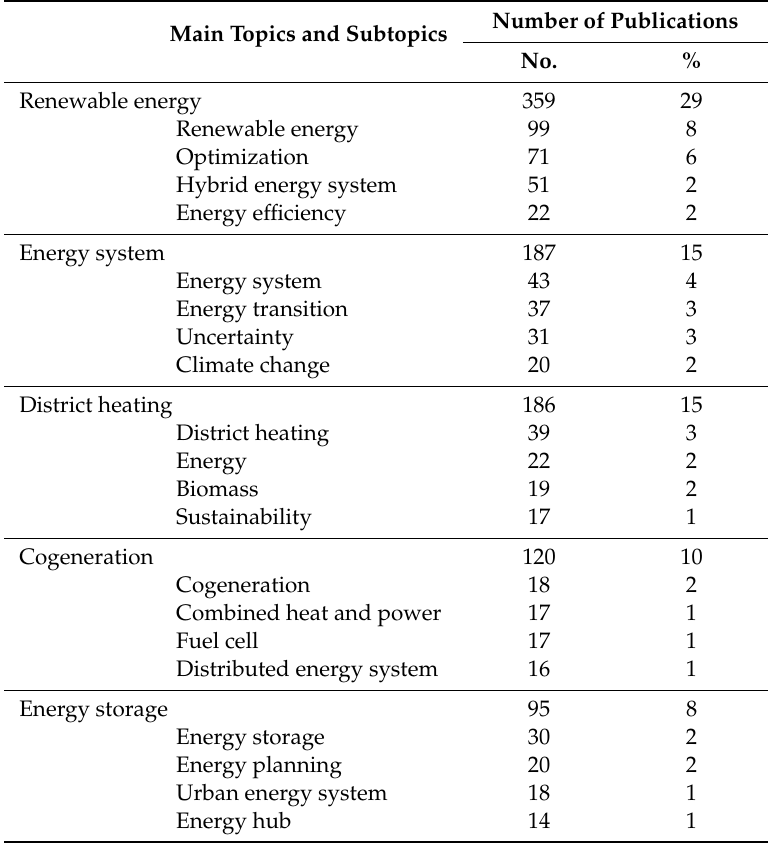
Table 10. Most important topics and subtopics in publications on municipal energy system planning. The percentage values refer to the total of 1235 publications.